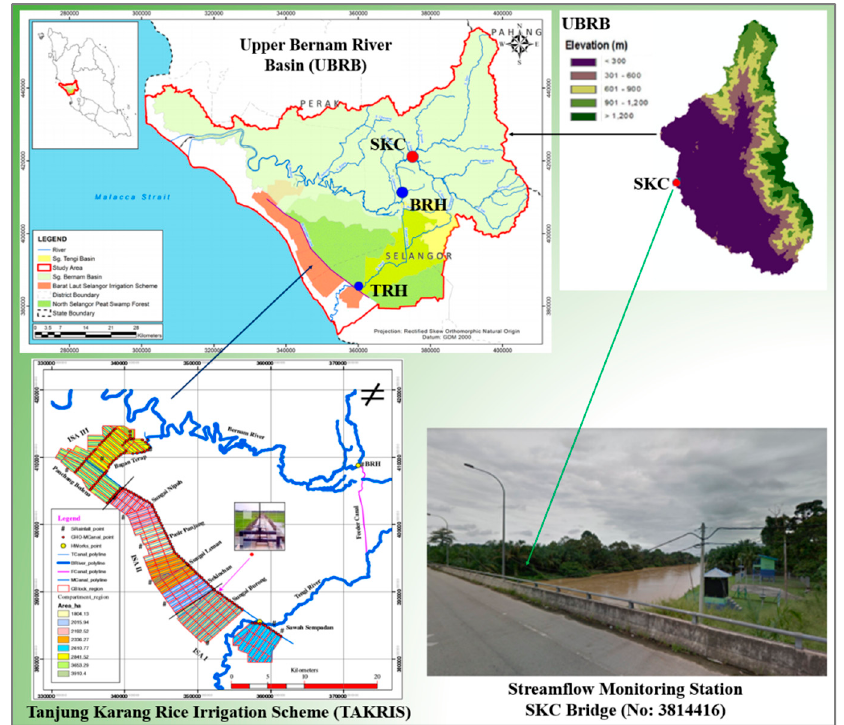
Figure 1. Map of the Tanjung Karang Rice Irrigation Scheme [26].